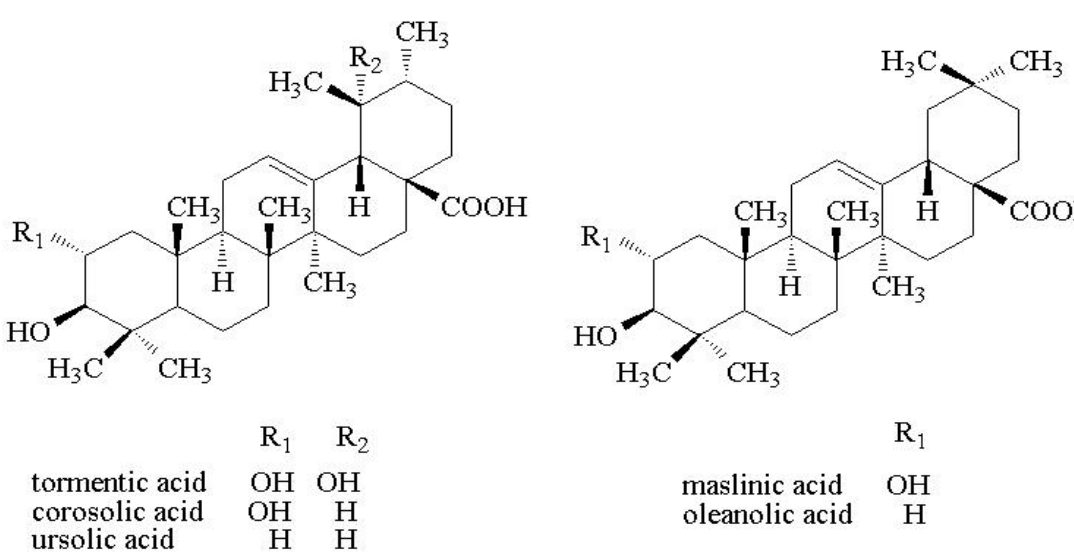
Figure 1. The chemical structures of five